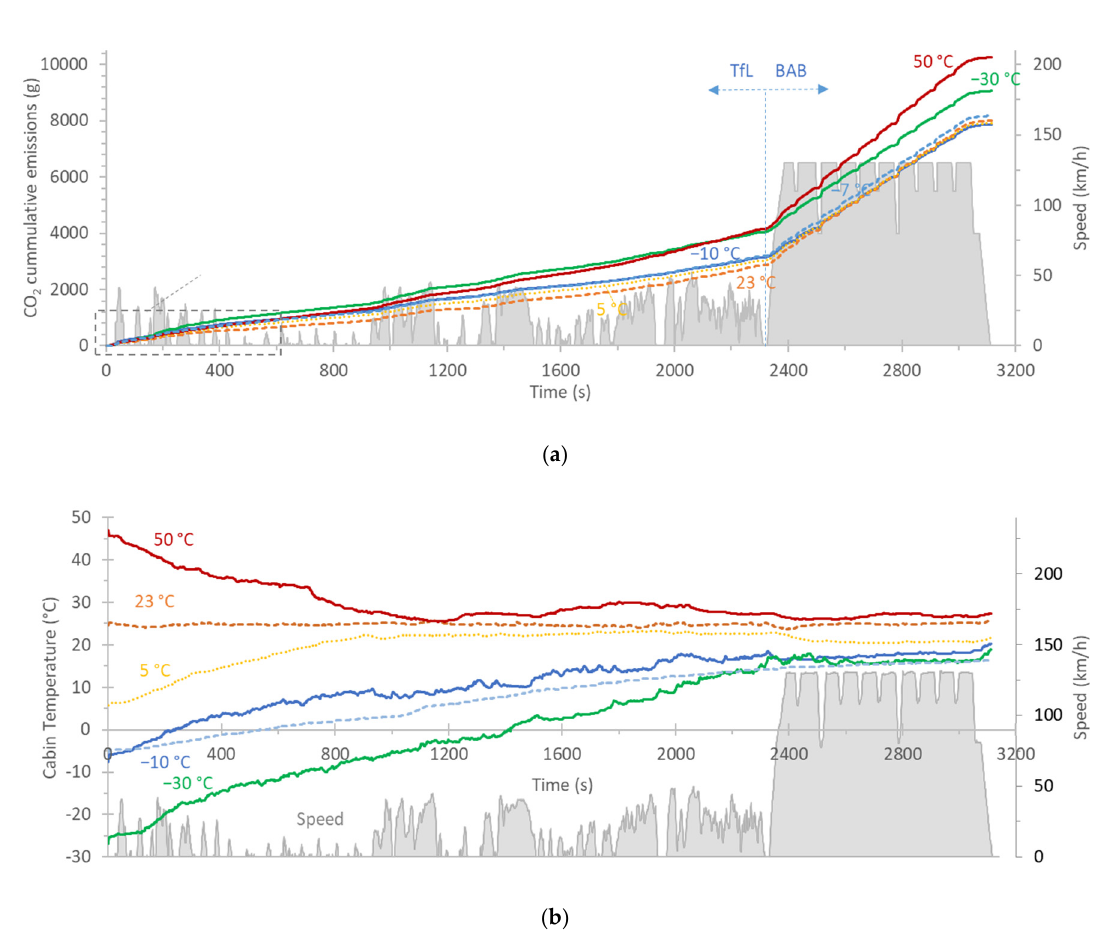
Figure 1. TfL and BAB cycles at different ambient temperatures ( − 30 °C to 50 °C): ( a ) cumulative CO 2 emissions (the inset focuses on the first 600 s) and ( b ) cabin temperature.